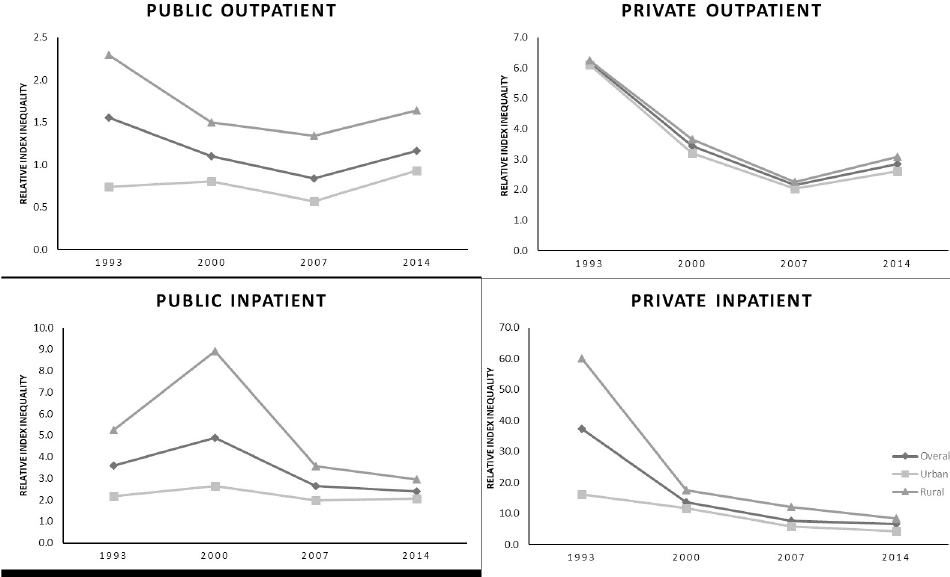
Fig 3. Trends of income-related inequalities in various type of healthcare utilisation by urban-rural area, 1993–2014.